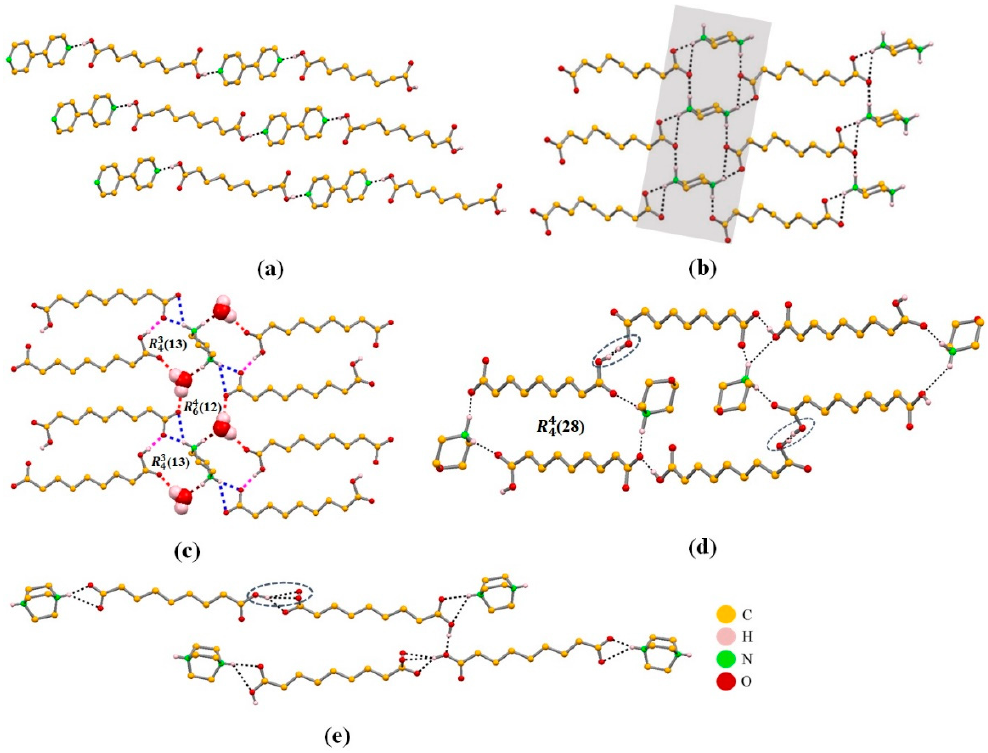
Figure 11. Packing diagrams showing the hydrogen bond OH COOH ··· N established in the co-crystal AA:BIP ( a ) and the charge-assisted interaction + N − H ··· O COO- in the molecular salts AA:PIP ( b ), AA:PIP: water ( c ), AA: MORPH ( d ), and AA:DABCO ( e ) [64].